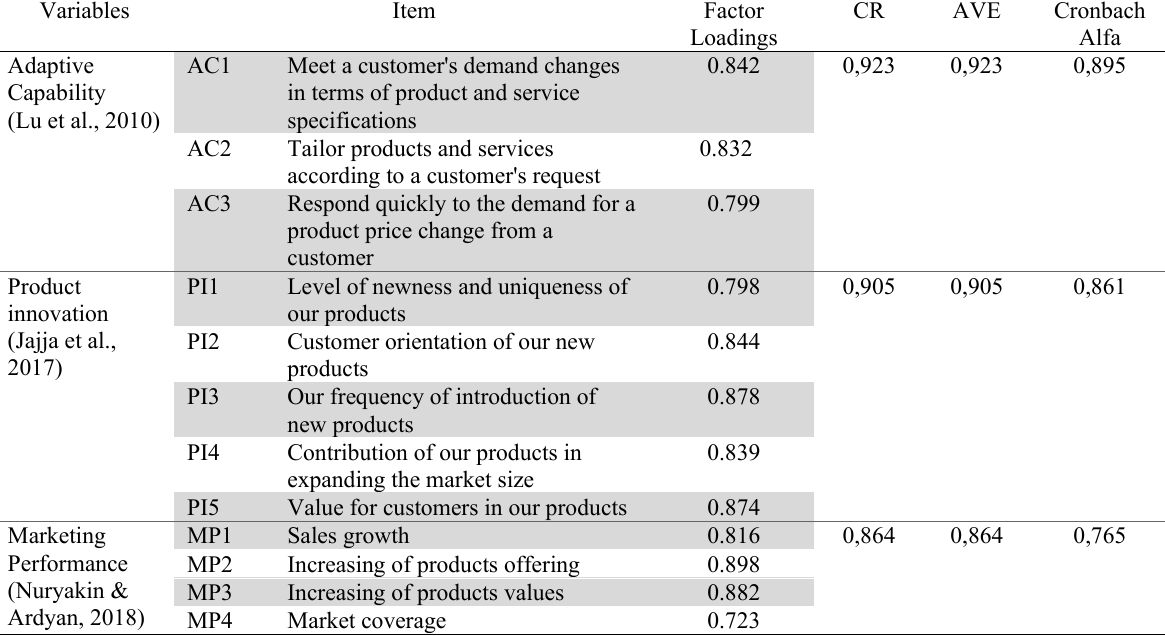
Measurement Model Evaluation Result